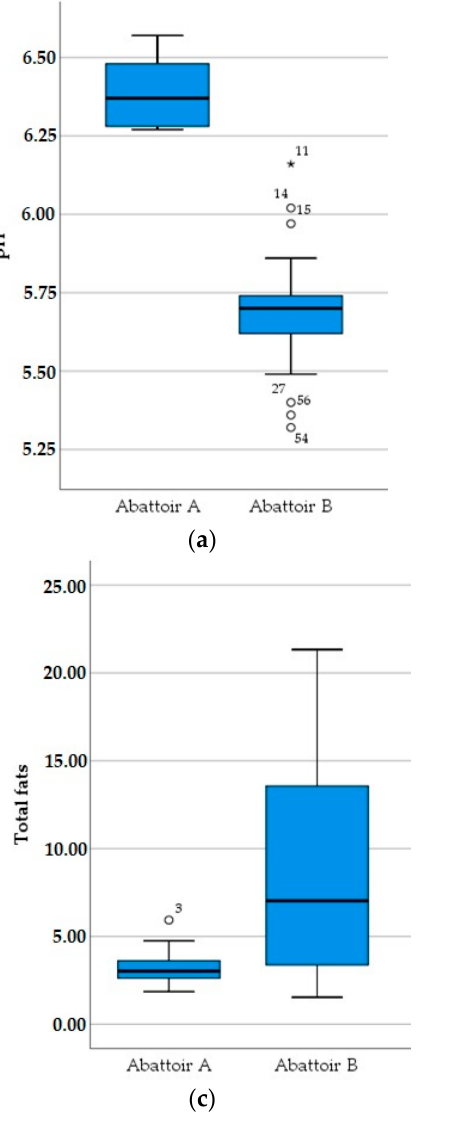
Figure 3. Meat pH ( a ), moisture ( b ), total fats ( c ) and total proteins ( d ) from the two abattoirs under investigation. * The star value is generally accepted as values exceeding the quartetiles. Table 4. Physicochemical analyses of sheep and goat carcasses, based on gender and age (average in bold, standard deviation in parentheses and italics).